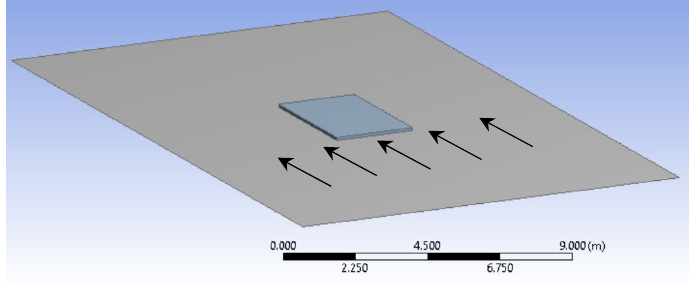
Figure 2. Simulation geometry.